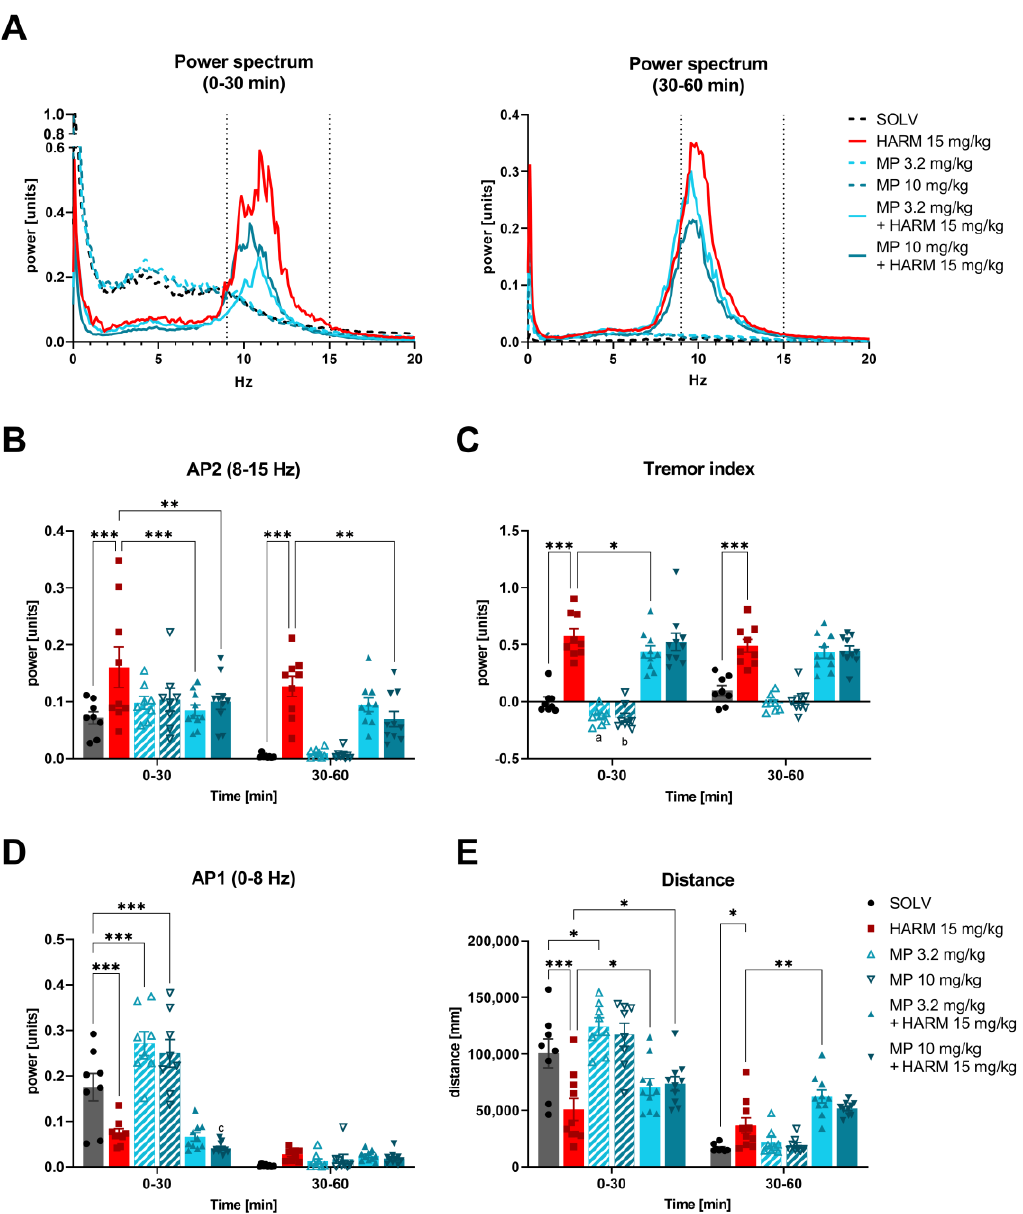
Figure 2. The effect of MP-III-024 (3.2, 10 mg/kg) on the harmaline-induced tremor: ( A ) power spectrum, ( B ) AP2, ( C ) tremor index, ( D ) AP1, and ( E ) locomotor activity (distance) of rats. The power spectrum within a range of 0–20 Hz, averaged over the two intervals (0–30 and 30–60 min) for all animals in each group is shown. Tremor parameter data are shown as the means ±